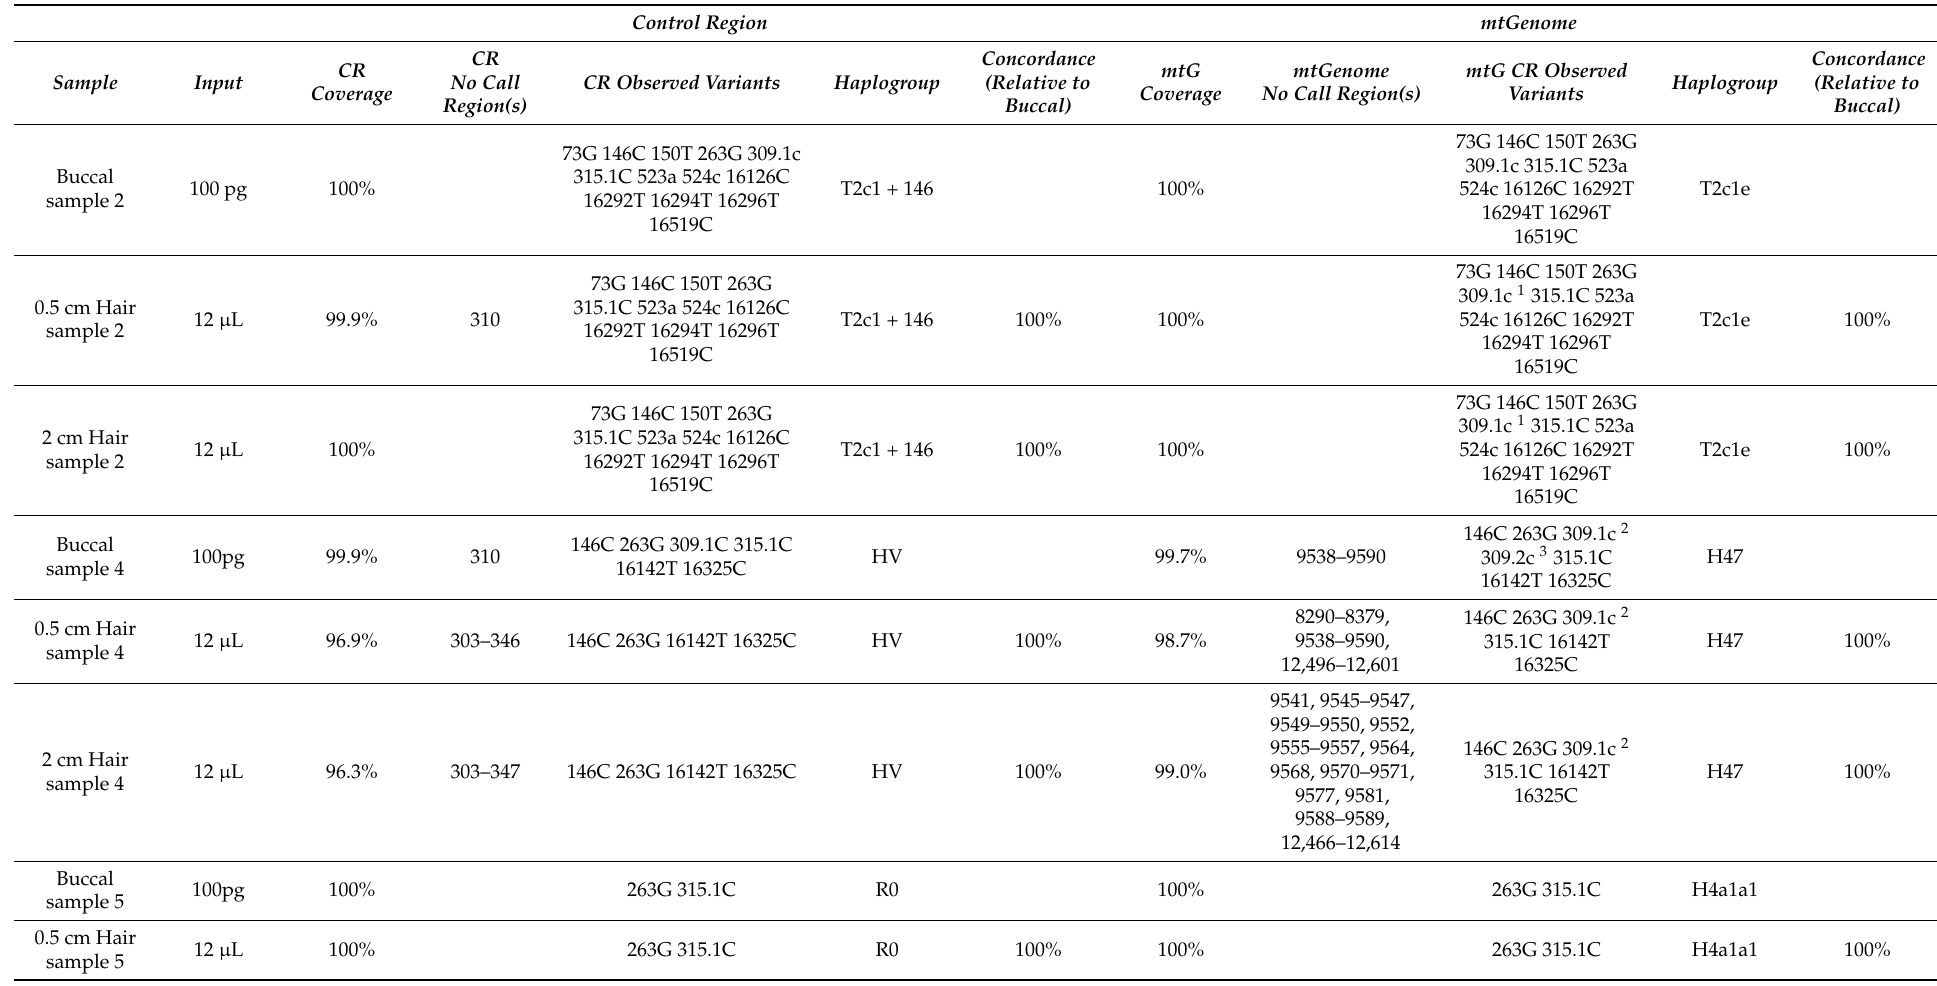
Table 2. Mock casework: control region and mtGenome coverage, variants and EMPOP haplogrouping, control region concordance between multiplexes and among matched buccal samples and rootless hair shafts from six